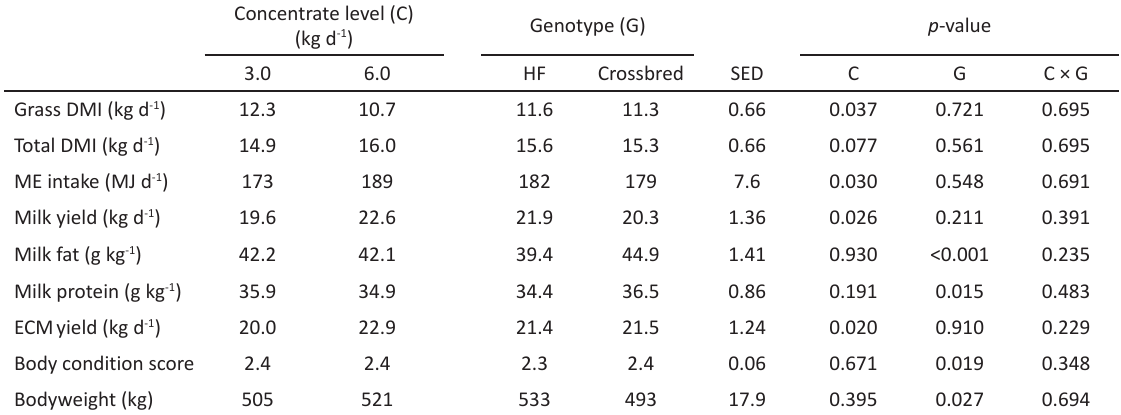
Table 1. Effect of concentrate feed level and cow genotype on feed intake and cow performance (average of the three methane measurement periods)